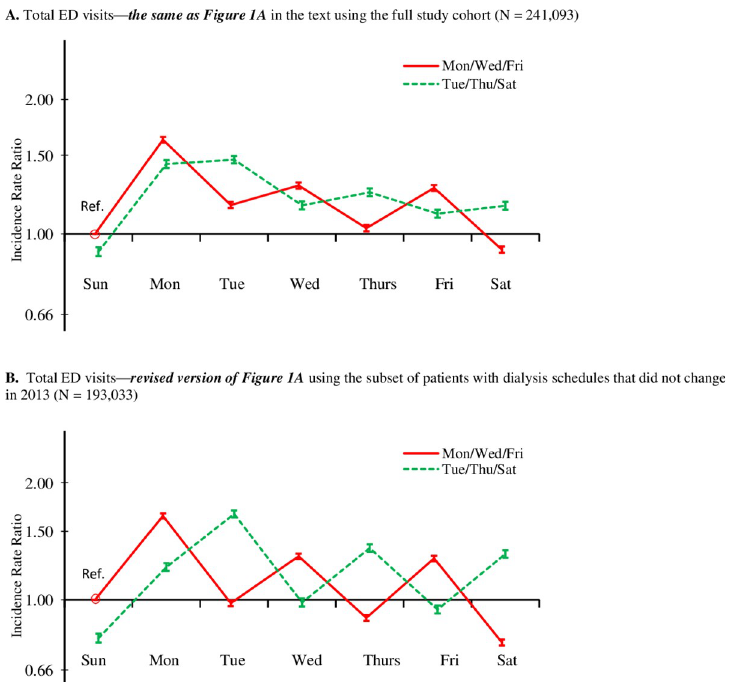
ED visits, by dialysis schedule (MWF or TTS) and day of the week, compared with the MWF group on Sunday (reference group). Incidence rate ratios were adjusted for age, sex, race/ethnicity, the Charlson Comorbidity Index score, HD vintage, HD session length, Kt/V, IDWG, and